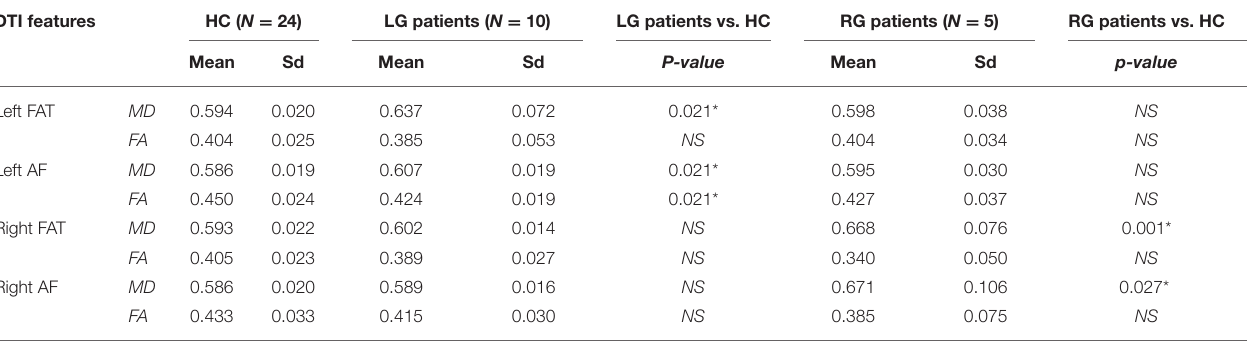
TABLE 4 | Comparison of DTI parameters between patients and healthy controls. DTI features HC ( N = 24) LG patients ( N = 10) LG patients vs. HC RG patients ( N = 5) RG patients vs. HC